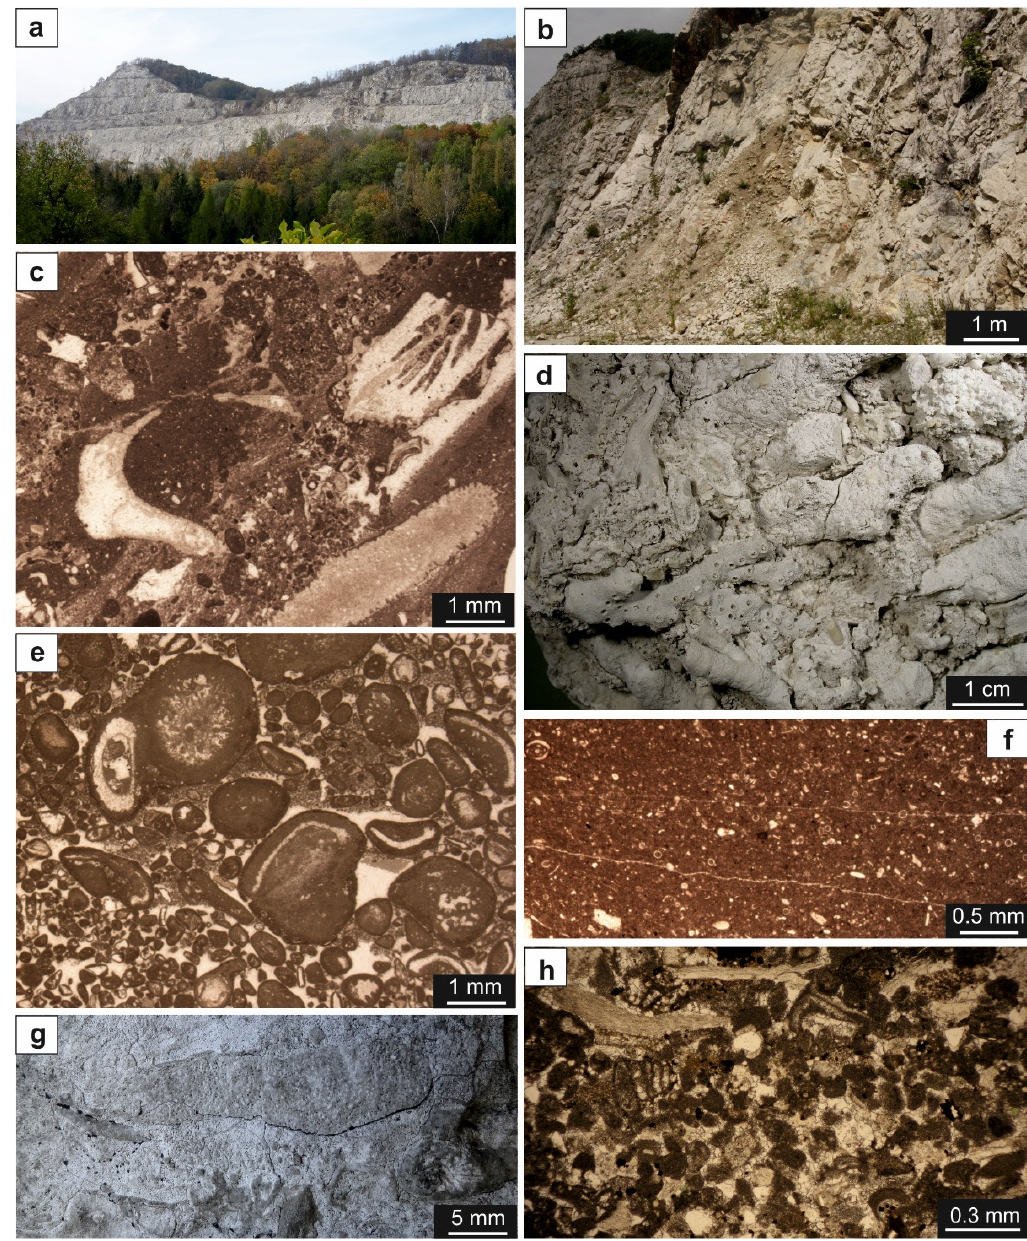
Figure 3. Štramberk-type facies association: ( a ) Štramberk—Kotou č Quarry; ( b ) shallow-water limestones in the Kotou č Quarry; ( c ) bioclastic-peloidal packstone with reefal components, such as fragments of corals and sclerosponges (exotic limestone from Krzyworzeka near Wieliczka); ( d ) reefal limestone with corals in the Kotou č Quarry; ( e ) coated packstone to poorly washed grainstone (exotic limestone from Zarzyce Wielkie near Wadowice); ( f ) wackestone with calpionellids (exotic limestone from Ż ywiec); ( g ) limestone with corals and calcified sponges (Štramberk—the Castle Hill Quarry); ( h ) allodapic limestone with components from the shallow-water Štramberk-type platforms (Cieszyn Limestone Formation, Goleszów near Cieszyn).